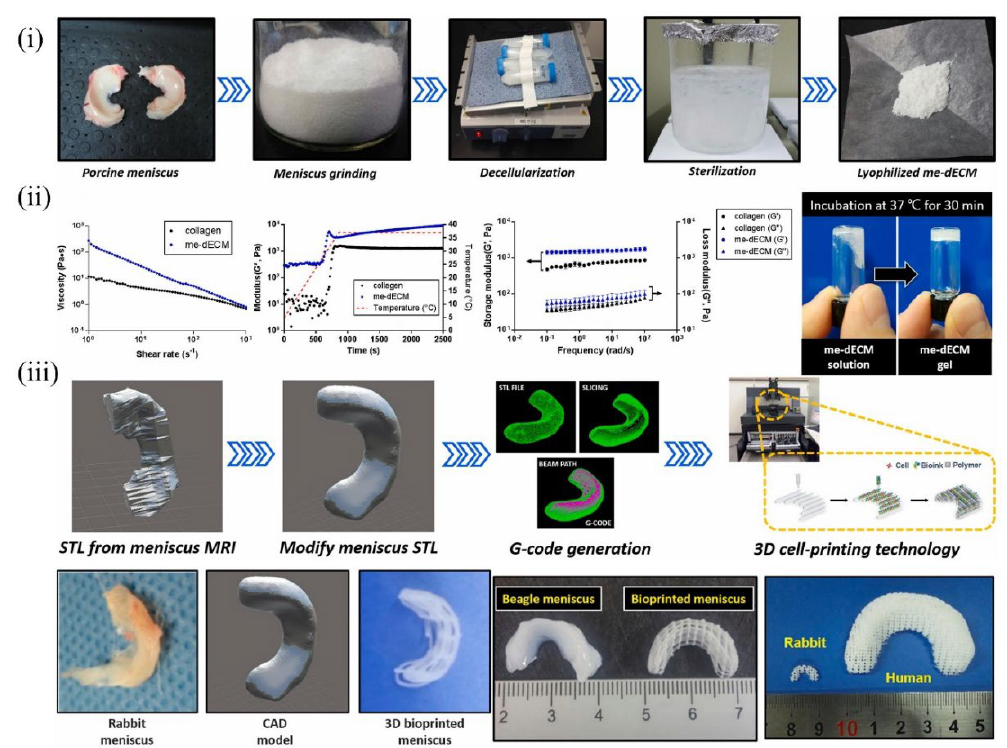
Figure 5. 3D bioprinting of biocompatible and functional meniscus constructs using